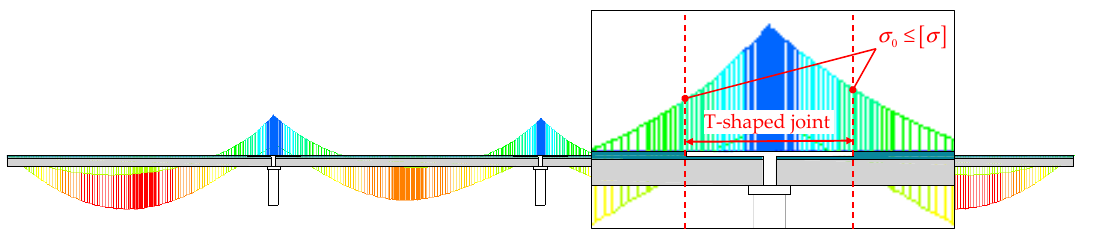
Figure 2. Bending moment envelops of common continuous beam bridge.